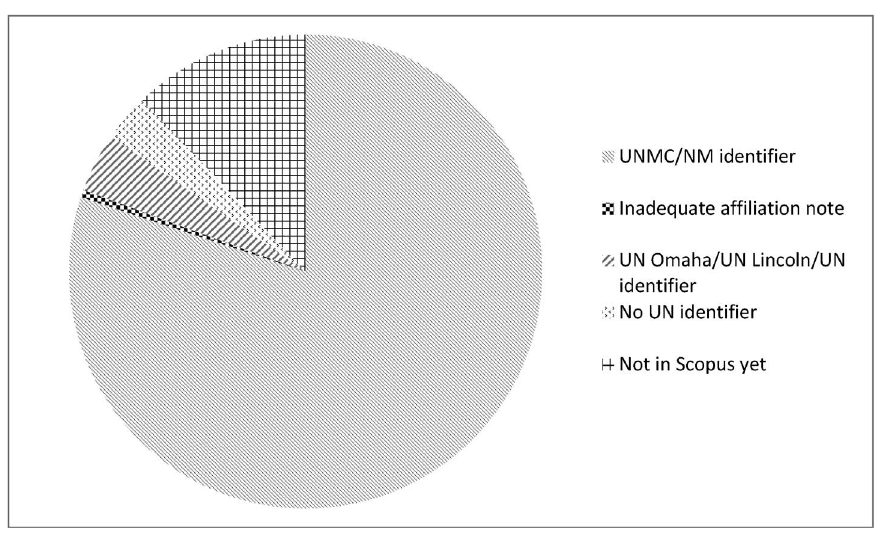
Figure 1 University of Nebraska Medical Center (UNMC)/Nebraska Medicine (NM)–authored articles published during 2014 according to their representation and/or affiliation designation in